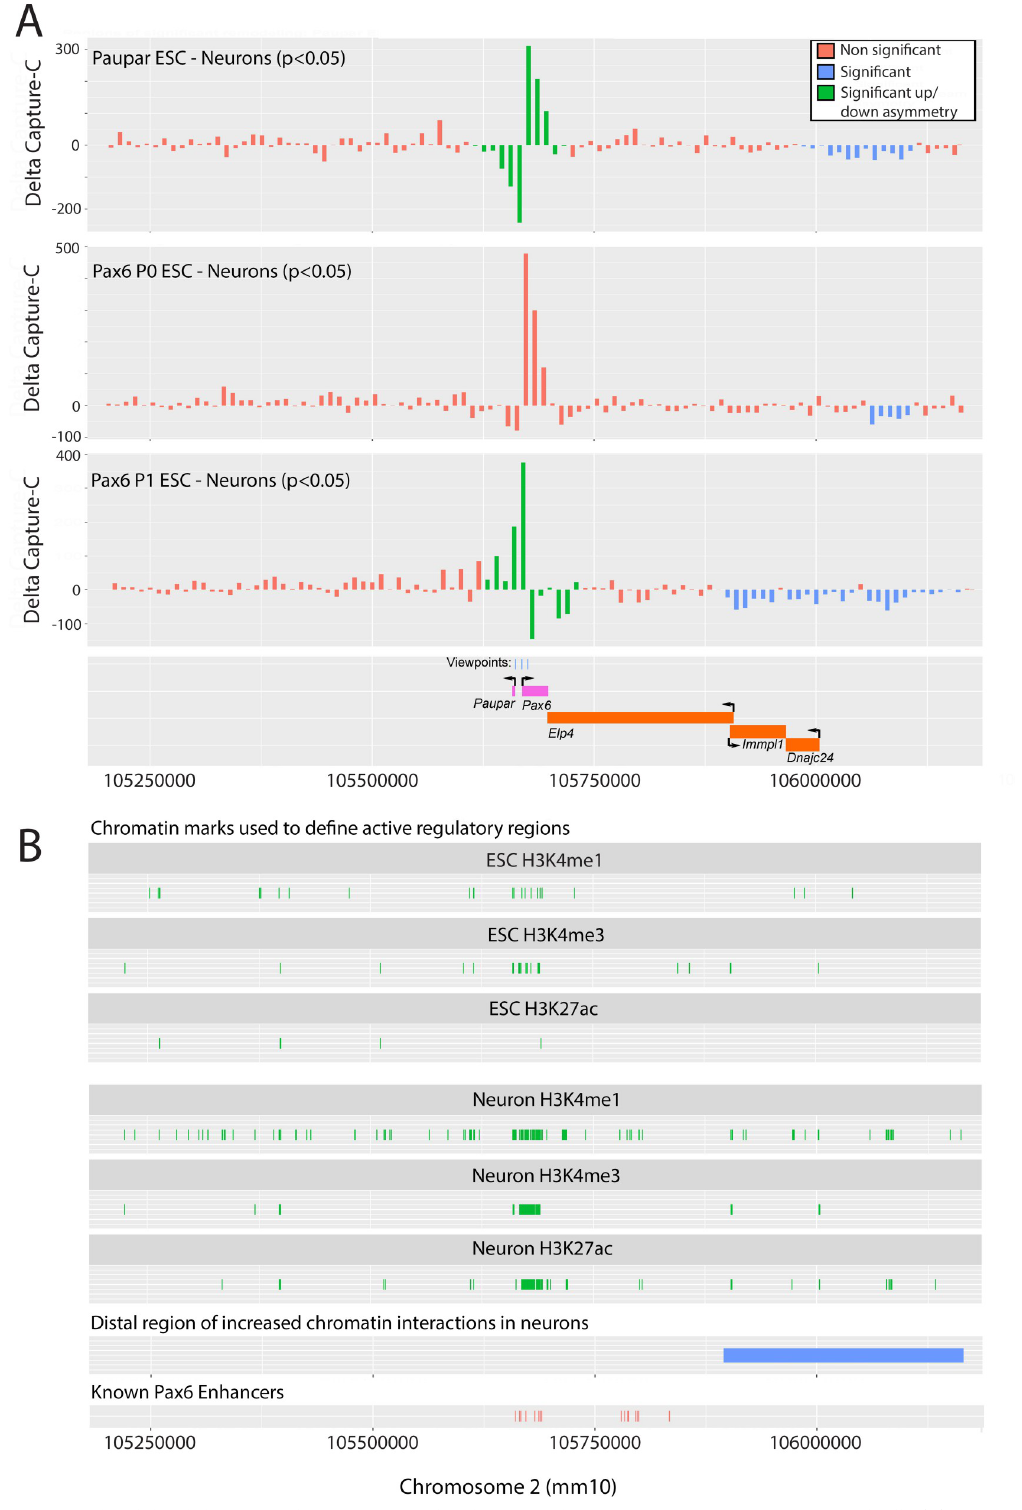
Fig 5. Local and distal chromatin changes associated with increased Paupar-Pax6 expression in neuronal cells. (A) A comparative analysis of NG Capture-C data to map changes in chromatin conformation between cell types. Differences in mean normalized capture counts for interactions with the Paupar (top), Pax6 P0 (middle) and Pax6 P1 (bottom) viewpoints